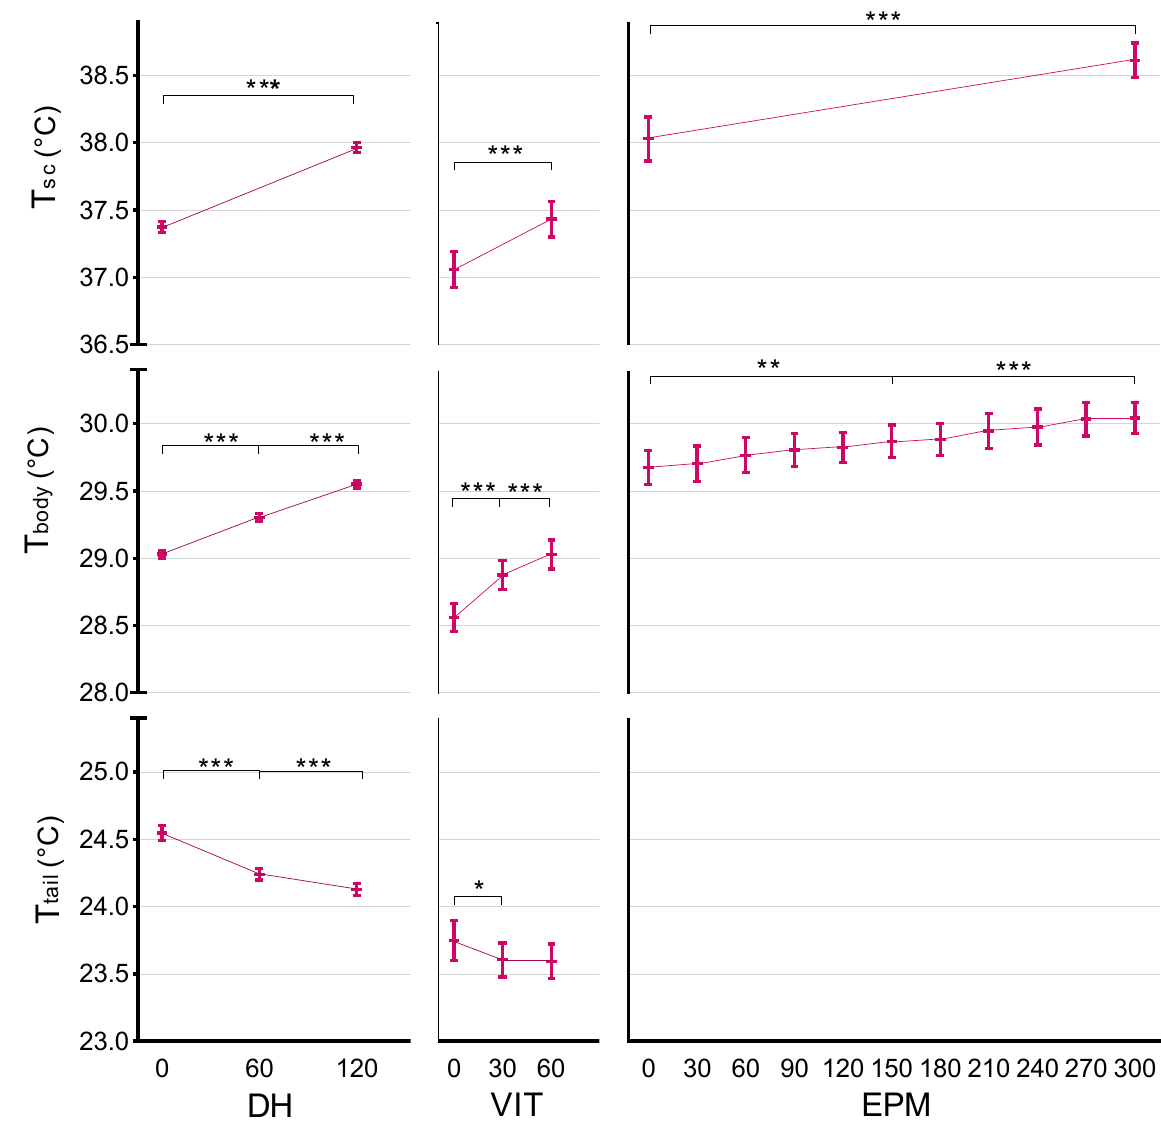
Figure 3. T sc , T body and T tail during Daily Handling (DH), Voluntary Interaction Test (VIT) and Elevated Plus Maze (EPM), at predefined time points, presented for all animals. Errors bars represent